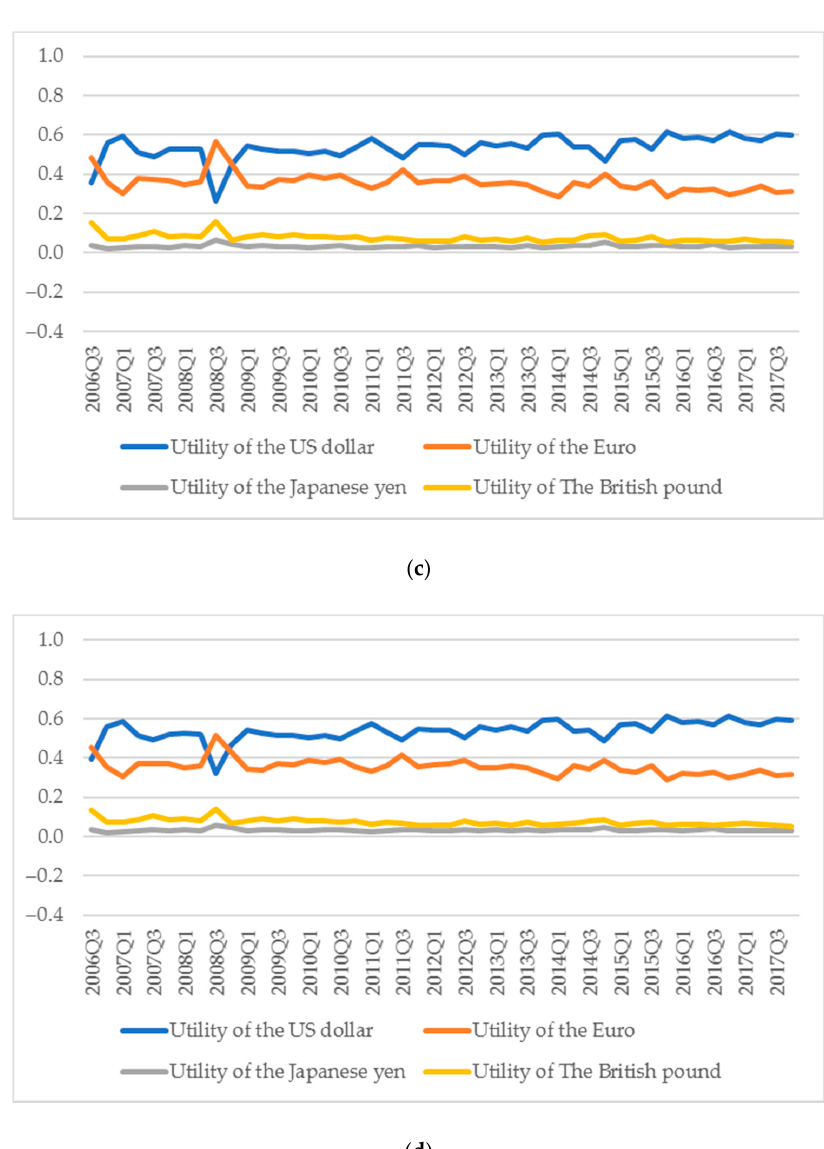
Figure 1. ( a ) Utility of international currencies (real interest rate = 1.5%). Notes: The four lines represent time series of estimated coefficients on four international currencies (the US dollar, the euro, the Japanese yen, and the British pound) in a money-in-the-utility function. The coefficients were estimated from share of holdings of an international currency and expected inflation rates with a real interest rate supposed to be 1.5%. We used BIS data on total of domestic currency denominated debt and foreign currency denominated debt of the euro currency market as the share of holdings of an international currency. The expected inflation rates are calculated rate of change of actual CPI level and expected CPI level estimated under the assumption that the price level of each period follows ARIMA (p, d, q) process. ( b ) Utility of international currencies (real interest rate = 2.0%). Notes: The four lines represent time series of estimated coefficients on four international currencies (the US dollar, the euro, the Japanese yen, and the British pound) in a money-in-the-utility function. The coefficients were estimated from share of holdings of an international currency and expected inflation rates with a real interest rate supposed to be 2.0%. We used BIS data on total of domestic currency denominated debt and foreign currency denominated debt of the euro currency market as the share of holdings of an international currency. The expected inflation rates are calculated rate of change of actual CPI level